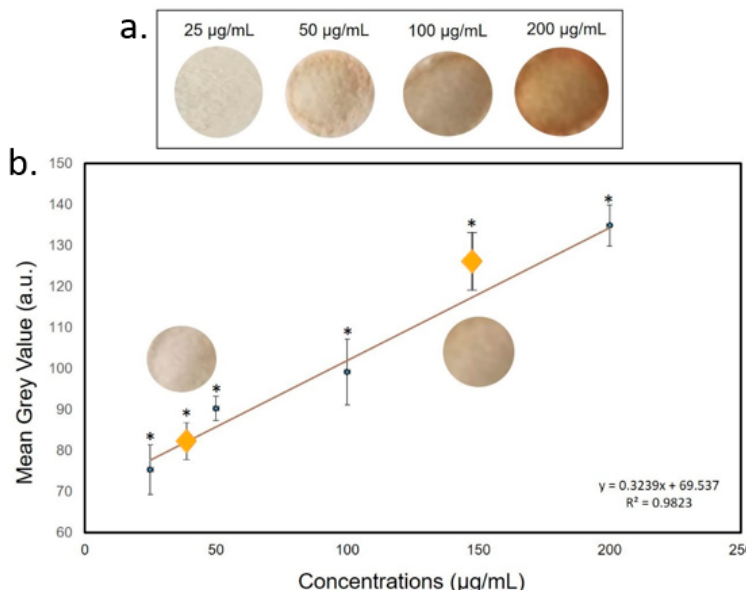
Figure 10. ( a ) Color change of filter paper after exposure to Cu(II) at different concentrations. ( b )The yellow rhombuses represented the interpolation of Cu 2+ intermediate concentrations (37 and 150 μ g/mL). Data reported were the average of three independent experiments ± SD. The difference between as-prepared paper and colored papers was considered statistically significant performing a Student’s t -test with p < 0.05 (<0.05 *).